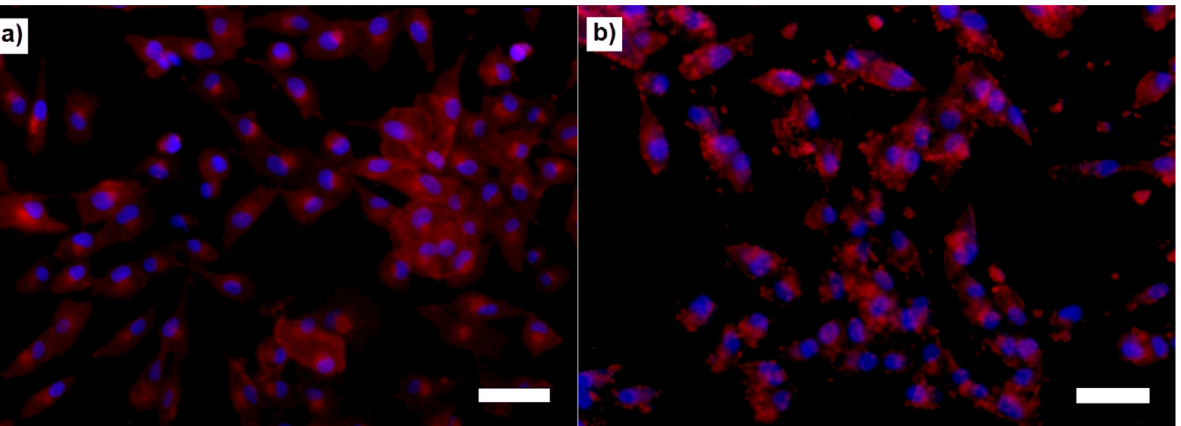
Figure 7. Cell viability of MG-63 cells treated with control (cells without any treatment), pure PHBV microspheres and composite microspheres at different MBGN ratios (ten-fold dilutions of 1 mg/mL), after 24 h of incubation. (* corresponds to p -value ≤ 0.05).